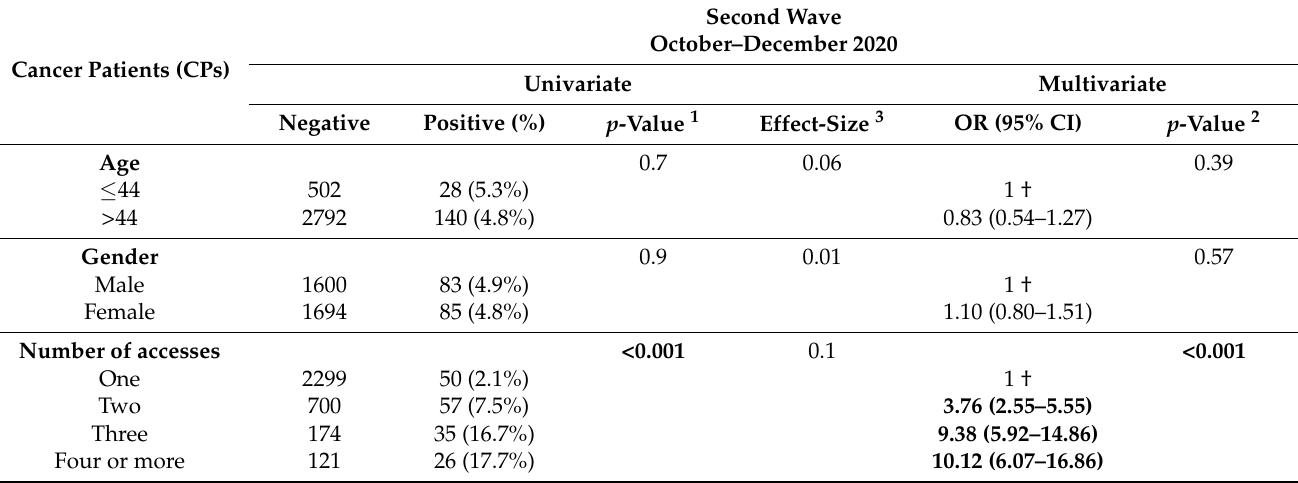
Table 5. Univariate and Multivariate analysis in the Second pandemic wave for